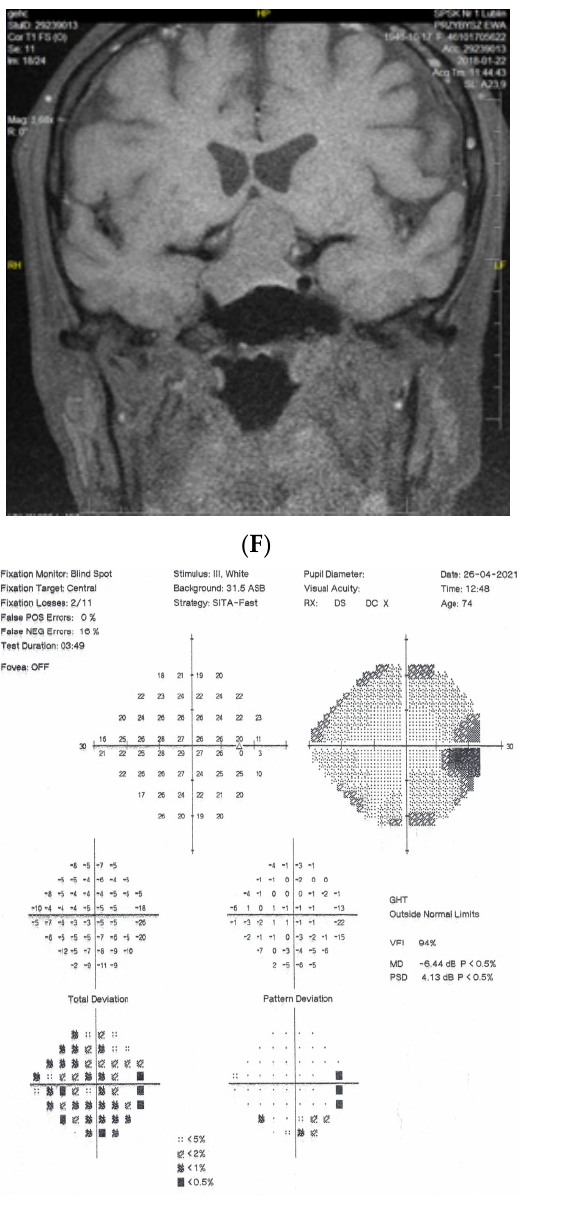
Figure 5. A 70-year-old female with pituitary gland macroadenoma. ( A ) Optic disc right eye. ( B ) Optic disc left eye. ( C ) Visual field right eye 04.2018 at initial visit. ( D ) Visual field left eye 04.2018 at initial visit. ( E ) OCT of optic disc with RNFL measurements 04.2018 at initial visit. ( F , G ) MRI scans with visible pituitary macroadenoma. ( H ) Visual field right eye 04.2021 after the neurosurgical intervention. ( I ) Visual field left eye 04.2021 aft.er the neurosurgical intervention.